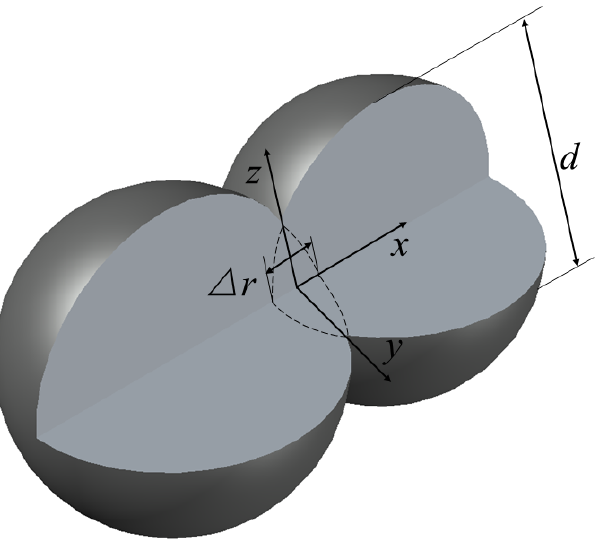
Figure 1. The structure diagram of the proposed Ag plasma dimer nanoparticle.